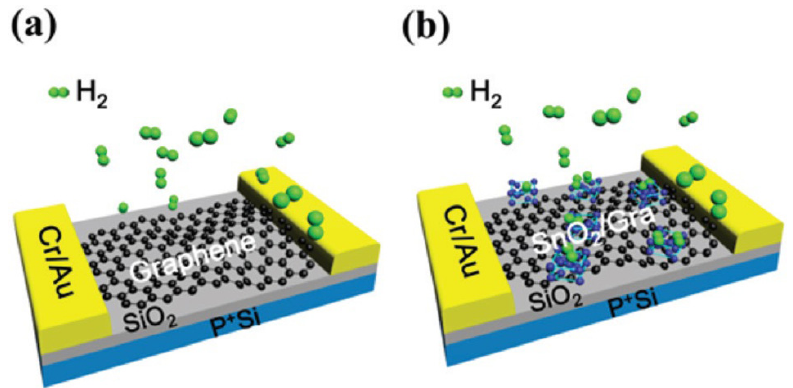
Figure 6. ( a ) The schematic of graphene transistor without obvious sensitivity to hydrogen; ( b ) The schematic of graphene field effect transistor (FET) decorated by metal oxide NPs with obvious sensitivity to hydrogen. Reprinted with permission from Ref. [131]. Copyright, 2015, Royal Society of